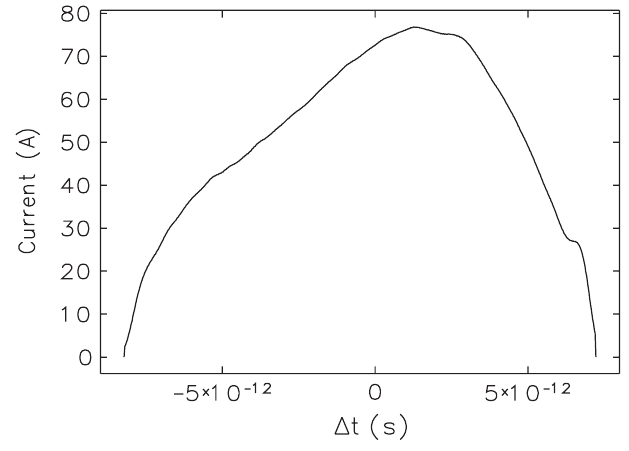
FIG. 1. Initial unperturbed electron beam current